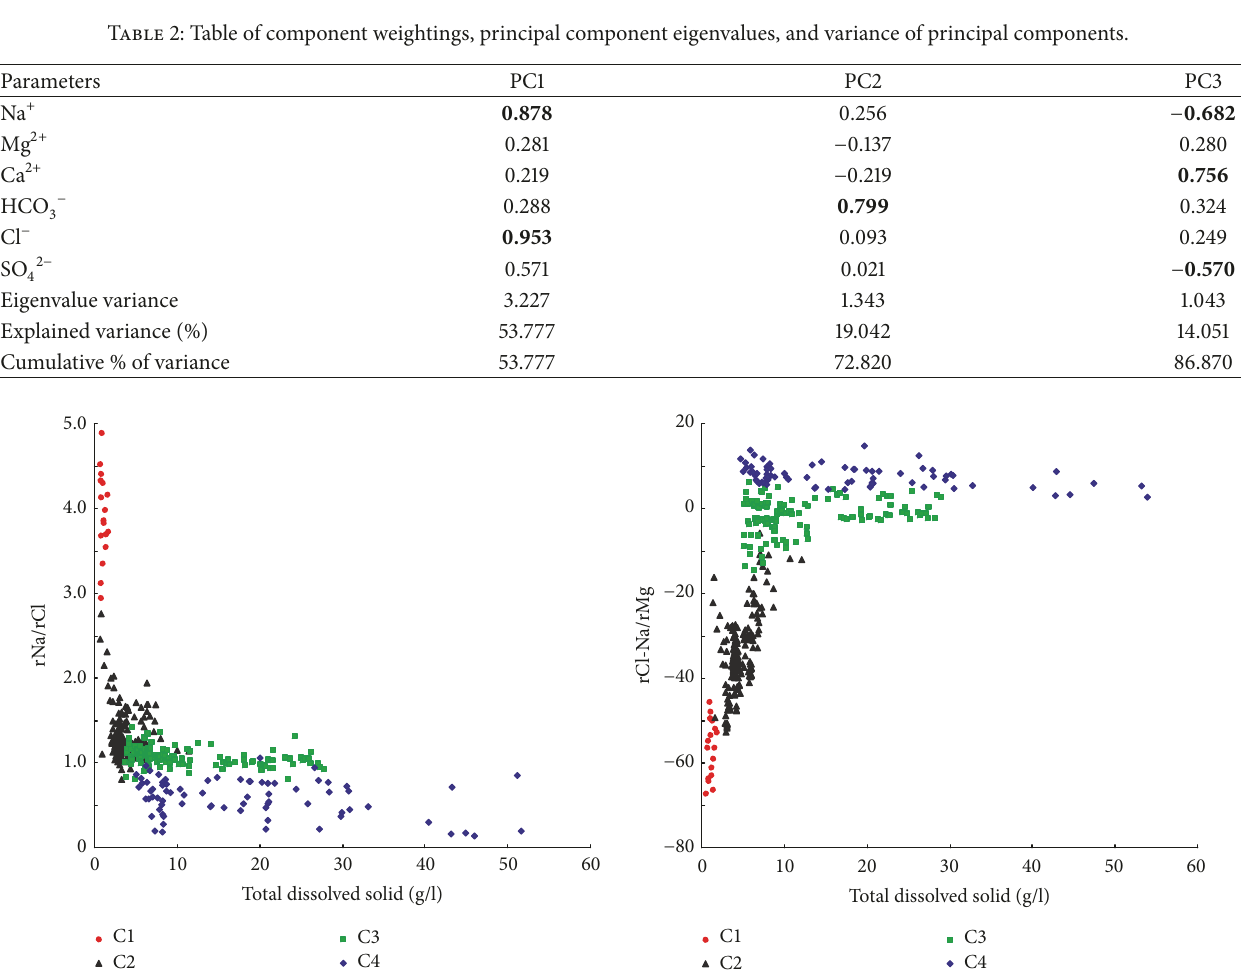
Figure 7: The relationship between salinity and sodium chloride coefficient and metamorphic coefficient from different types of formation water in buried hill of Jizhong